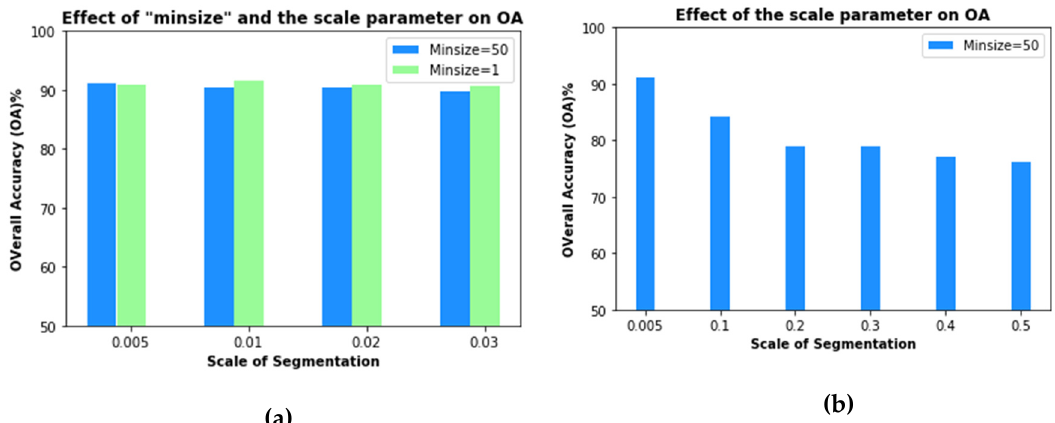
Figure 5. A chart illustrating influence of both scale and the minimum number of pixels in a segment on the overall accuracy (OA) of the FCN _obia approach in ( a ) and the influence of only the scale parameter in ( b ).